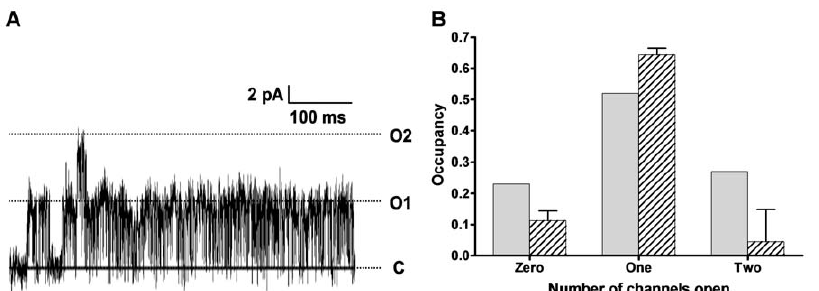
Figure 1. K ATP channels exhibit less noise than expected for identical and independent channels. A. A representative patch clamp recording of individual K ATP channels from a patch containing no more than two simultaneously open channels. B. Deviation of observed occupancies (dashed bars) in states with zero, one, or two simultaneously open channels from the occupancies predicted by the binomial distribution (light gray bars), which assumes identical and independent channels with the same apparent P open (error bars, S.E.M., p =0.013, n =5). Stationary recordings of 100 s in duration were analyzed. The excess occupancy in the ‘‘one open’’ state compared to the ‘‘two open’’ and ‘‘zero open’’ states indicates a variance lower than that predicted by the binomial distribution.